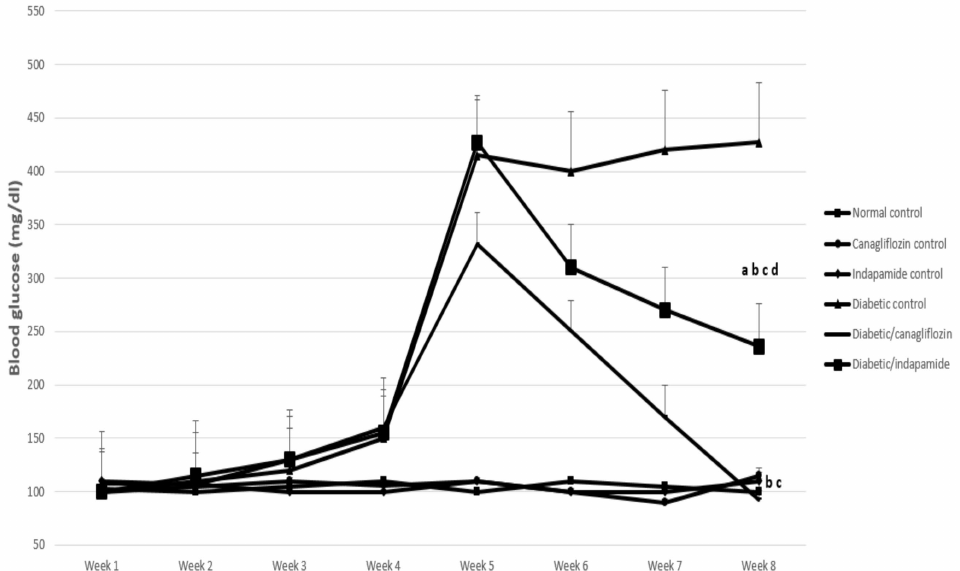
Figure 2. Impact of daily CANA and INDA treatment on blood glucose: oral CANA and INDA treatments were initiated once daily for 4 weeks. Data represent the mean ± S.E.M. (6 rats/group). ANOVA followed by post hoc Tukey–Kramer test at ( p < 0.05) was used for statistical compar- ison; a against normal CTRL, b against diabetic CTRL, c against initial blood glucose, d against diabetic/CANA.